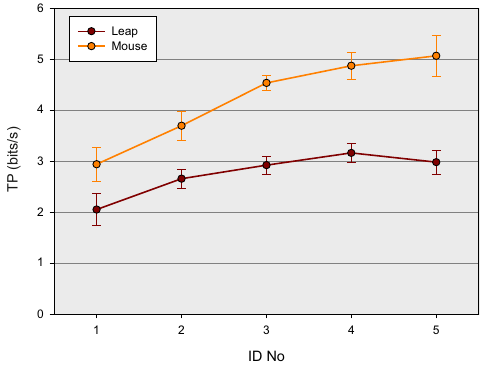
Figure 5. Result of the experiment: throughput ( T P ), the main indicator to estimate the performance of users as a function of device and ID